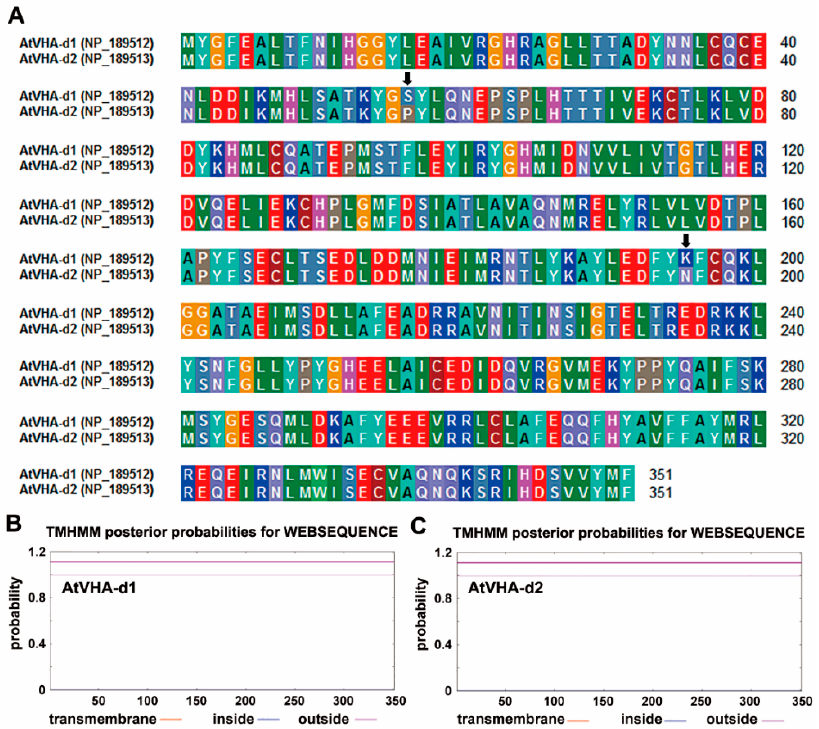
Figure 1. Sequence analysis of AtVHA-d1 and AtVHA-d2 proteins. (A) Amino acid sequence alignment of AtVHA-d1 and AtVHA-d2. The same color residues indicate identical residues in each sequence. The arrows indicate two different amino acids. Transmembrane domain prediction of AtVHA-d1 (B) and AtVHA-d2 (C) .